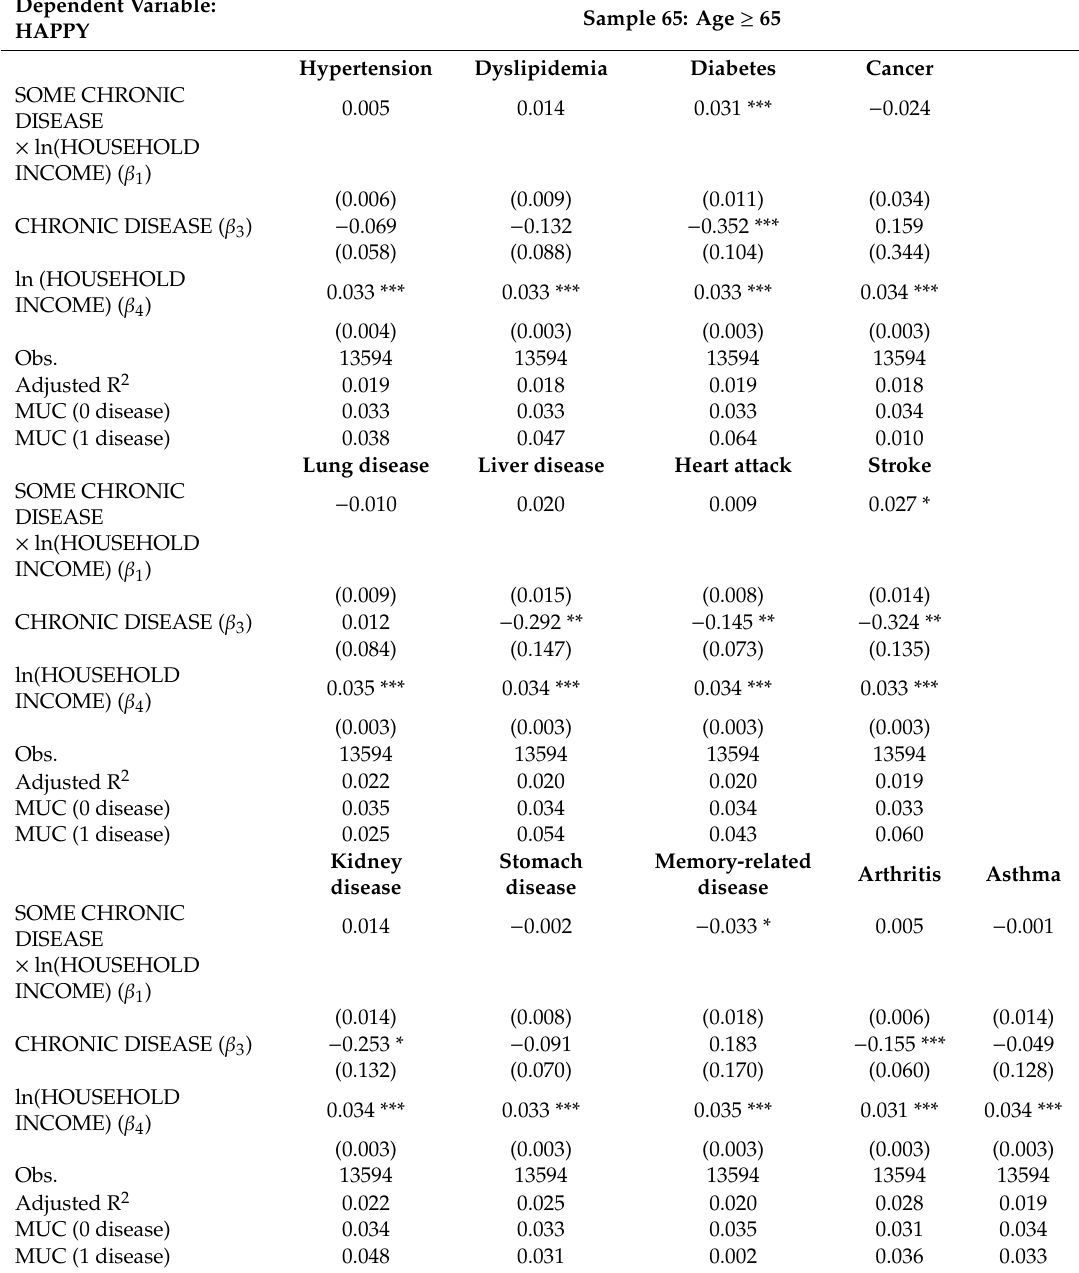
Table 6. E ff ect of a chronic disease on marginal utility of consumption (Sample